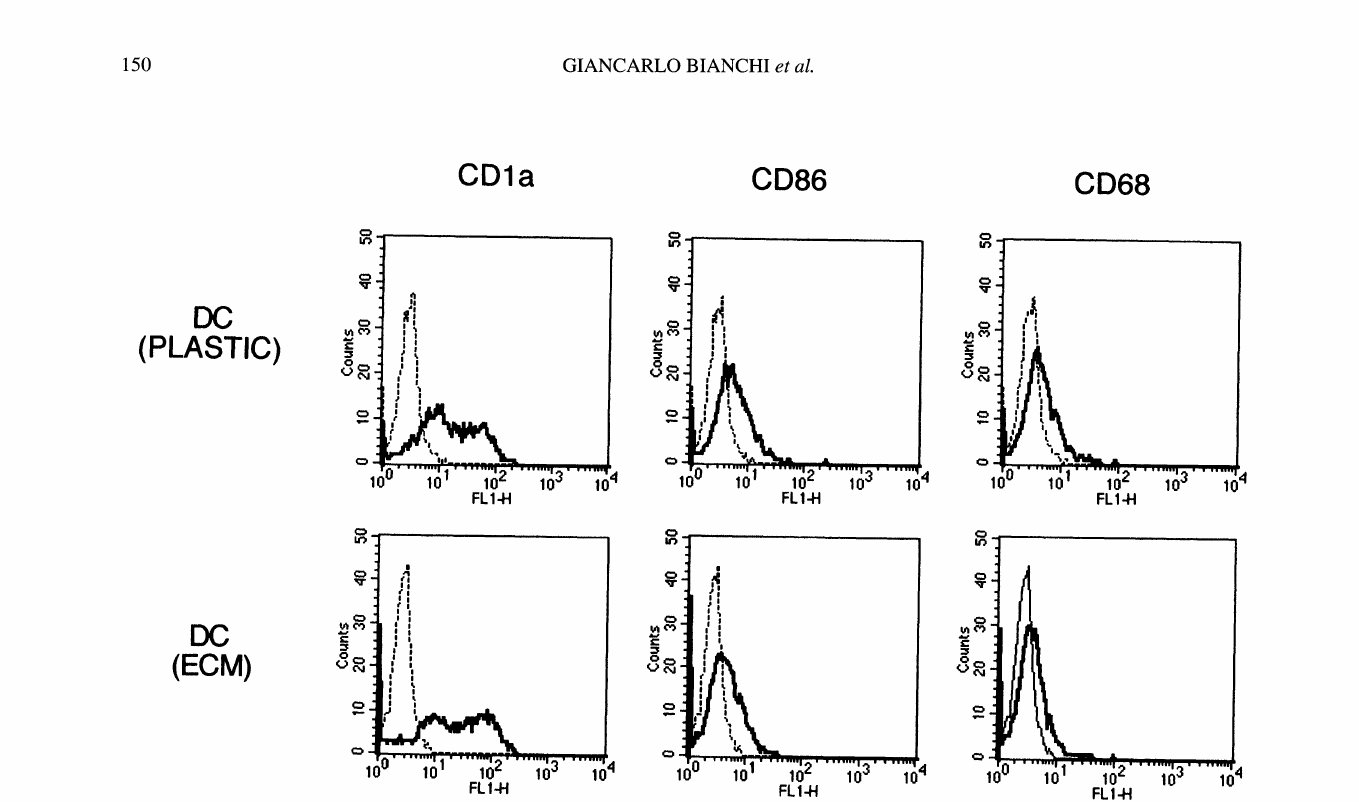
FIGURE 5 Flow cytometric analysis of membrane molecules expressed by DC differentiated on ECM-coated tissue culture plates. Mono- cytes were cultured with 50 ng/ml GM-CSF and 20 ng/ml IL-13 for 7 days on standard tissue culture plates or on ECM-coated plates pre- pared by stripping a monolayer of EC (see M&M). Cells were labeled with the designed mAb and then with FITC-labelled goat anti